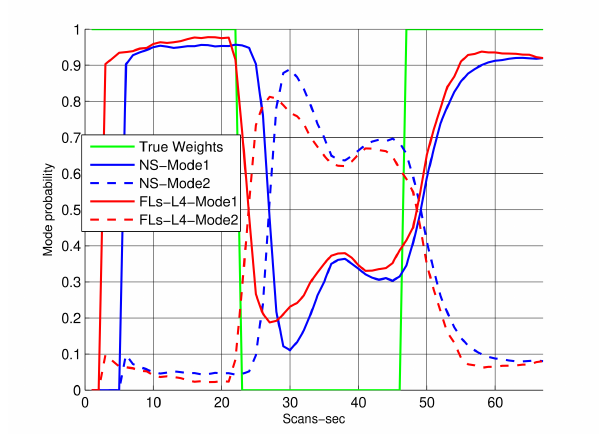
Figure 7. Mode probabilities (the smoothing lag is 4).